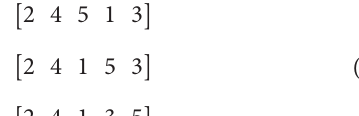
The pulse emission rate 𝑟 𝑖 will control the subsegment local operation. For each individual, randomly generate a random number; if this random number is larger than its 𝑟 𝑖 , this position of bat individual will be updated by random swap two segments defined by frequency 𝑓 ; otherwise, the updating operation will be implement by random inserting operation; the pseudo code can be described as shown in Algorithm